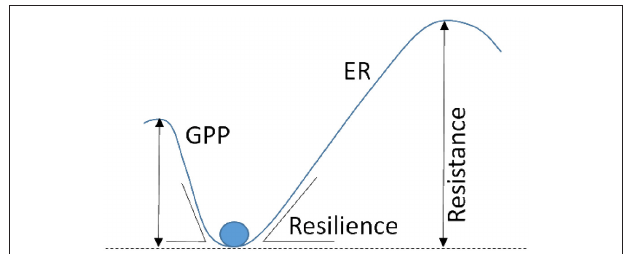
FIGURE 4 | Stability valley of stream metabolism under flow intermittency. The gross primary production (GPP) has a much steep slope (left), and ecosystem respiration (ER) a softer other (right). In this valley, the height of the slopes are indicative of the energy needed to move the respective metabolism process outside this stability valley, and are therefore representative to their resistance to disturbance. In this particular valley of ecosystem metabolism under flow intermittency, there is no symmetry in the slopes, so that the same disturbance energy (duration of flow intermittency) may cause different effects on GPP and on ER. The gradient of the slope is indicative of the energy that the biofilm will have when returning to the initial position once the disturbance vanishes, an equivalent to its